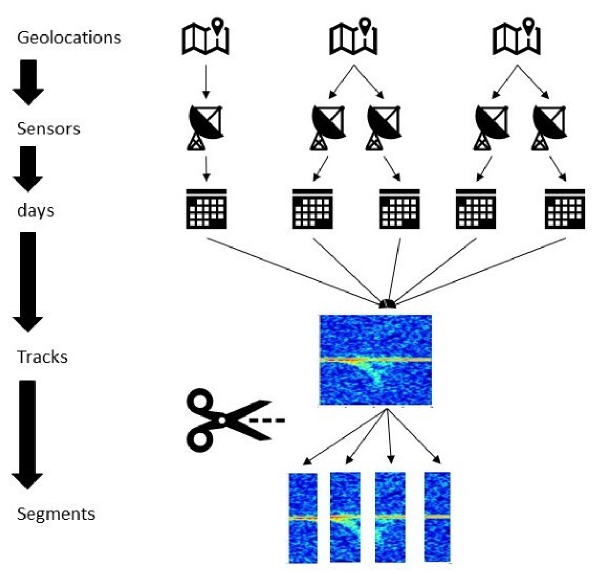
Figure 1. Explanation of MAFAT